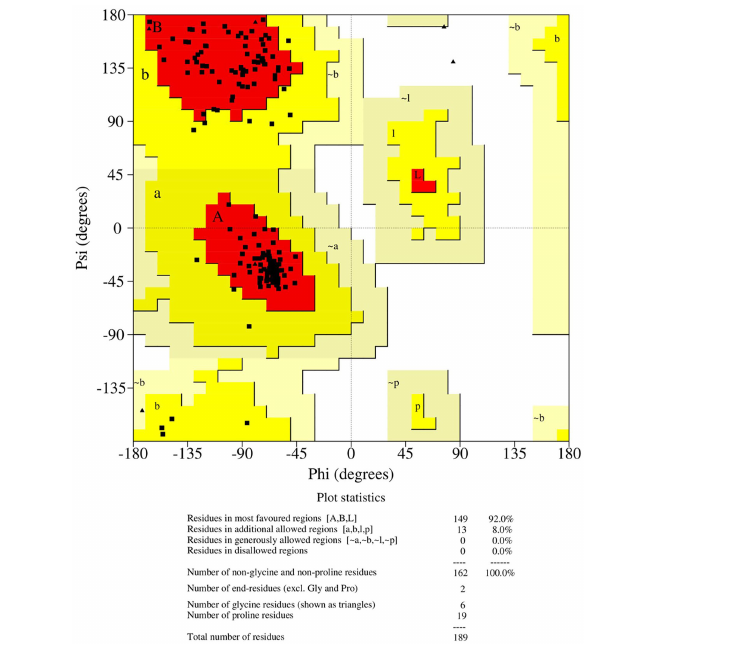
FIGURE 5 Ramachandran plot of the loop refined protein structure of ASP_NL4-3.